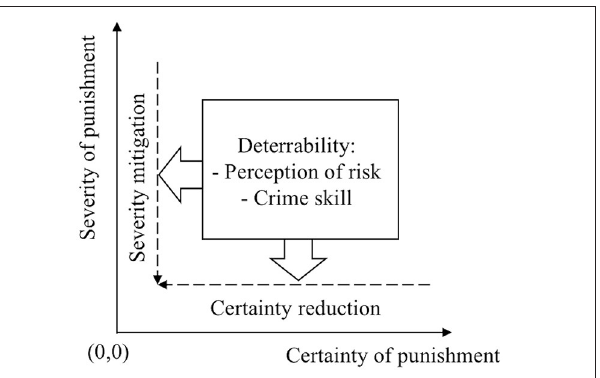
FIGURE 2 | Theoretical